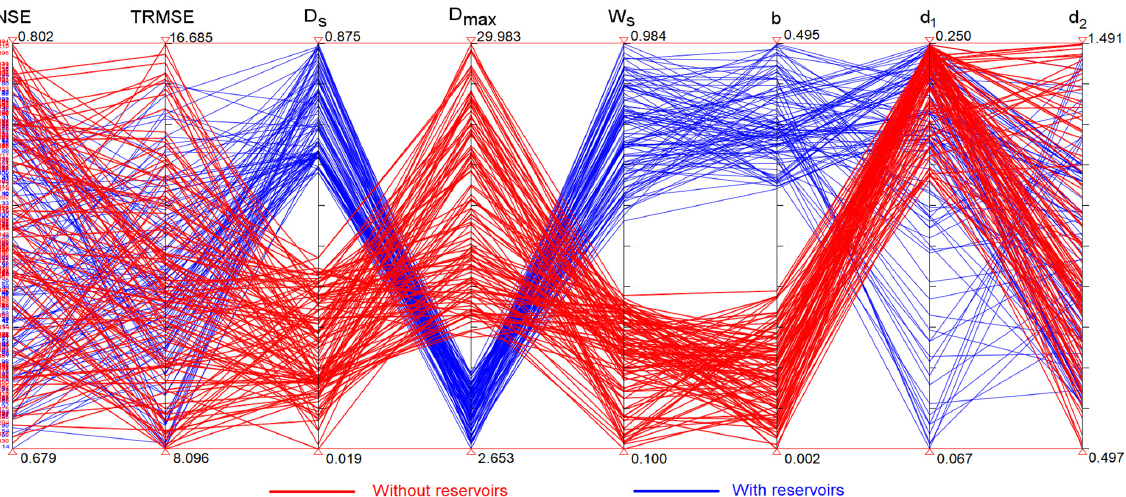
Figure 6. Parallel coordinate plot illustrating the values of the goodness-of-fit statistics (NSE and TRMSE) and model parameters ( D s , D max , W s , b , d 1 and d 2 ) obtained through the optimization-based parameterization exercise. Each line connecting the axes represents a parameterization, along with the corresponding model performance. Blue and red lines denote parameterizations obtained with and without